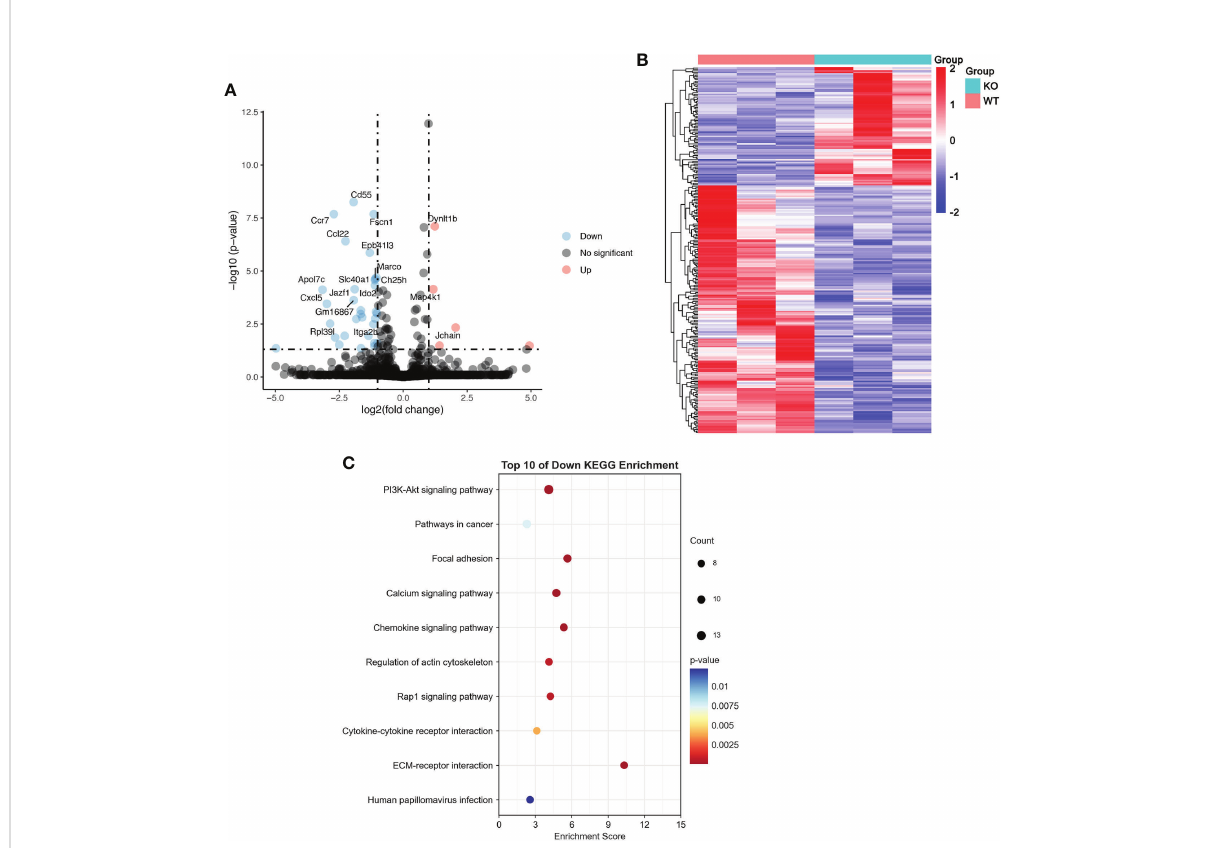
FIGURE 6 RNA-seq results of LPS-treated BMDMs with or without TRIM21 depletion (A) Volcano plot of DEGs between WT and TRIM21 -/- in BMDMs treated with LPS for 12 h. Red color indicates genes that are upregulated and blue color indicates downregulated genes. (B) Heatmap of color- coded expression levels of DEGs. (C) Top 10 KEGG down regulated signaling